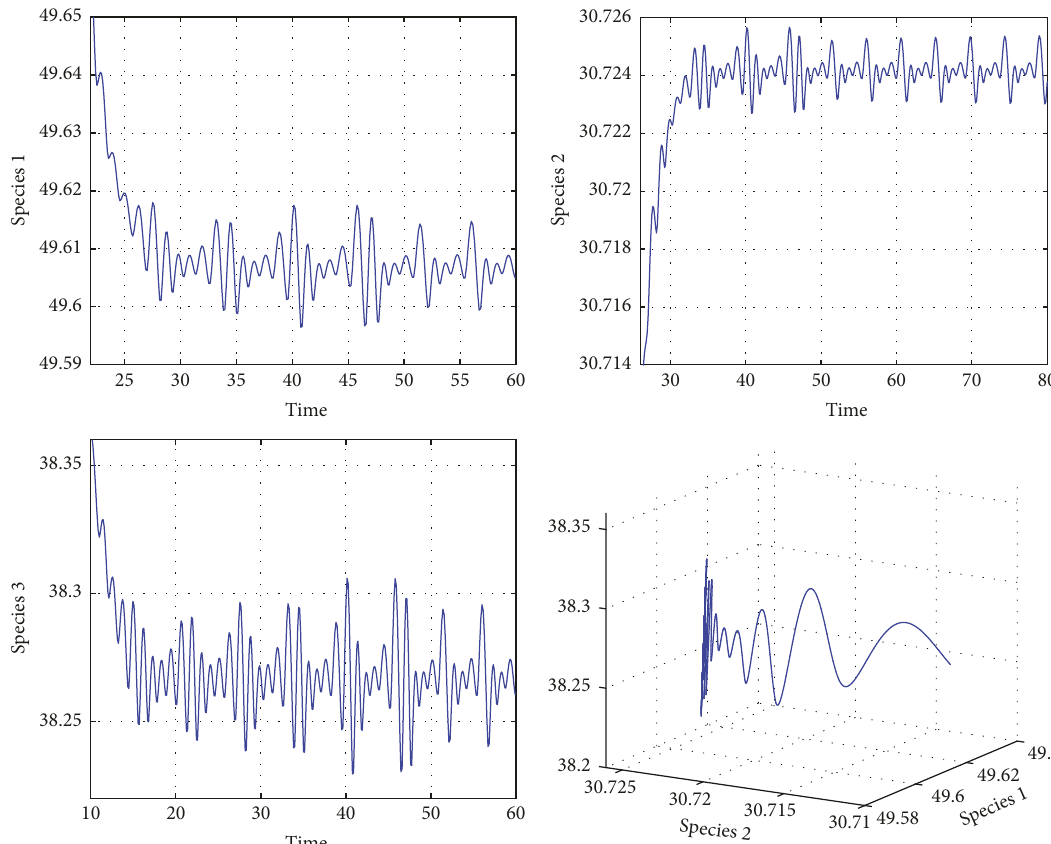
Figure 1: Dynamical behaviors and phase space trajectories of the three marine